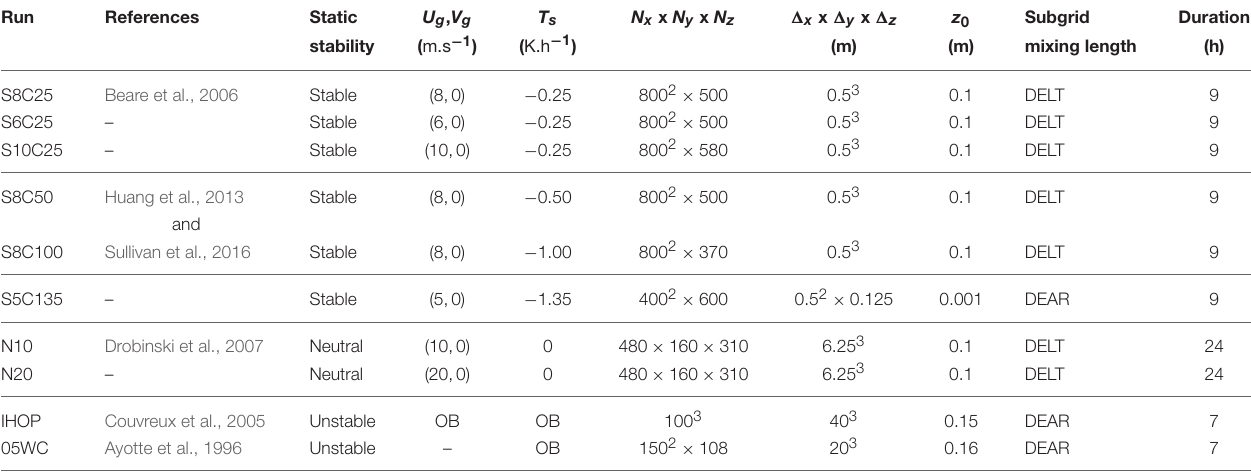
TABLE 1 | Brief description of the LES experiments (see text and references for more